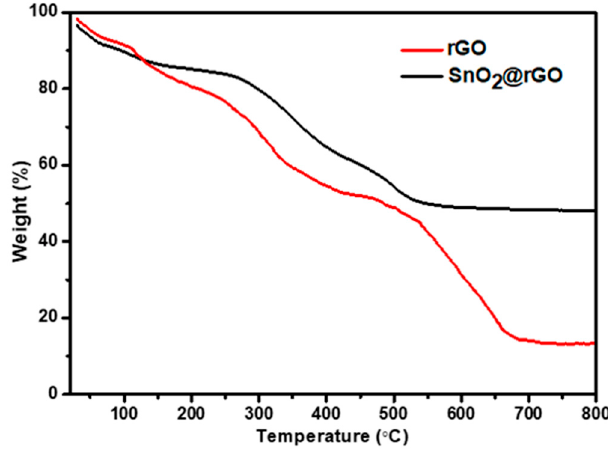
Figure 4. Thermogravimetric analysis of rGO and SnO 2 @rGO nanocomposite.